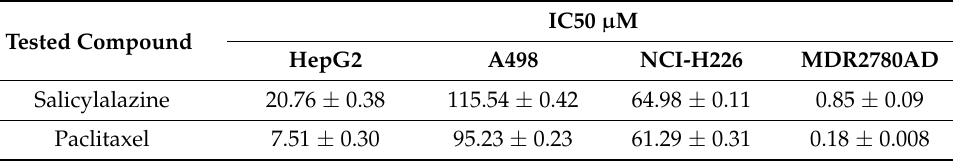
Table 4. In vitro anticancer effect of salicylalazine isolated from M. biflora .